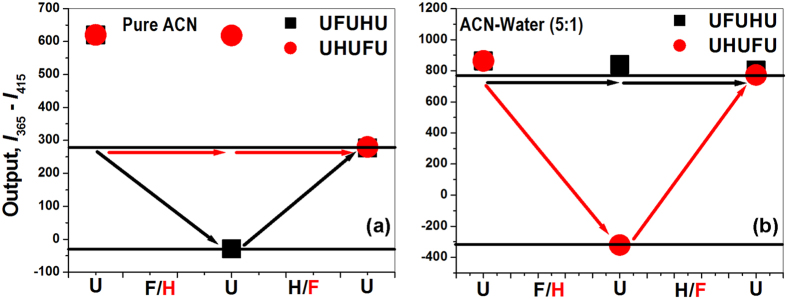
Password trajectories in pure ACN (a) and ACN-Water (5:1 (v/v)) (b) solvents. Variations of output “3” (I365 – I415) for each optical input, “U” throughout the full course of password entry.